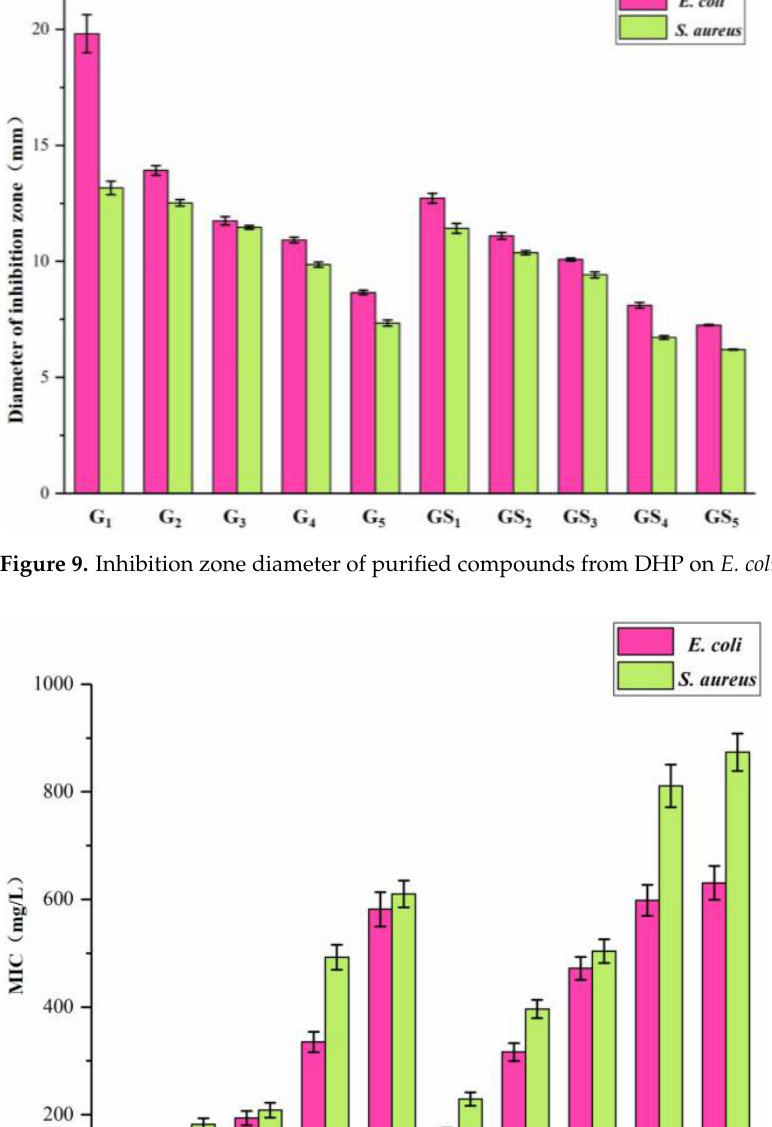
Figure 8. Inhibitory effect of purified components from DHP on the growth of S. aureus. Legend: